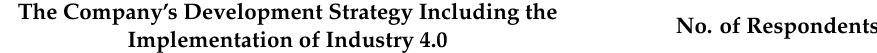
Table 14. The company’s development strategy including the implementation of Industry 4.0